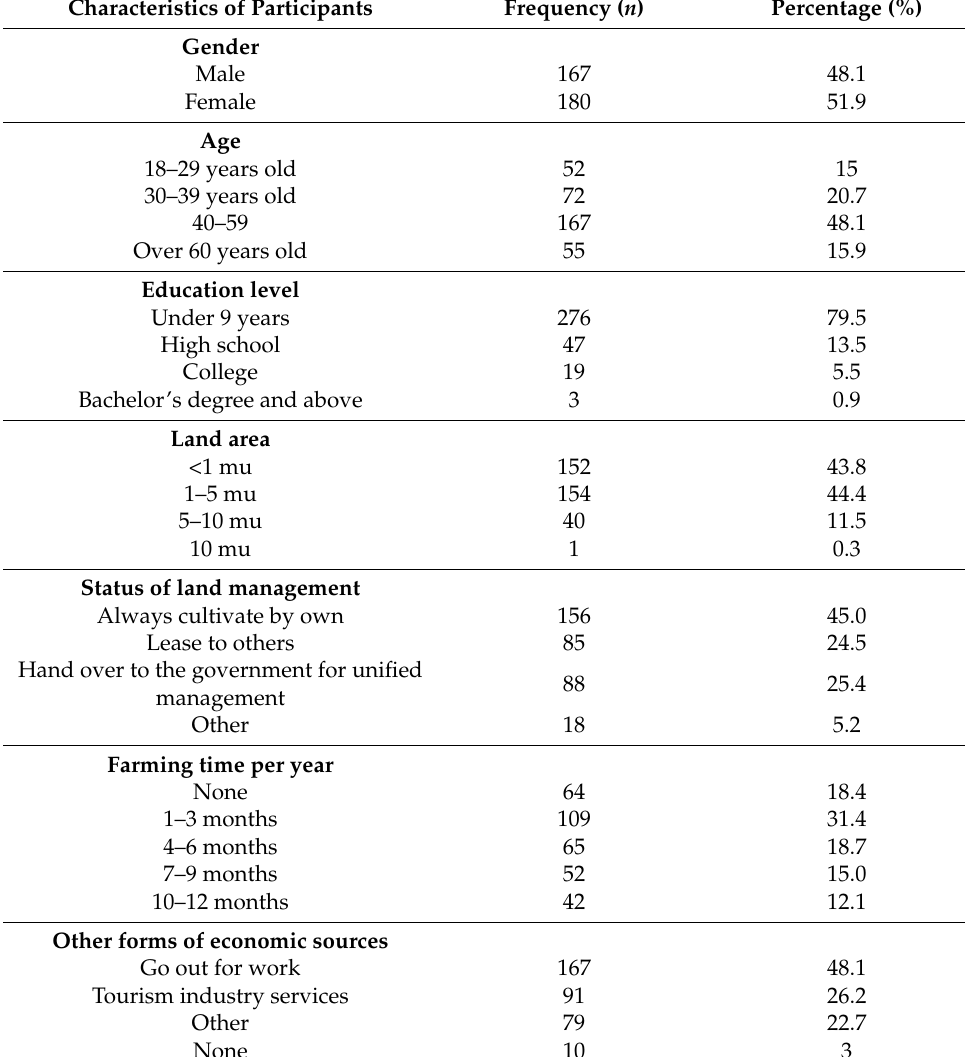
Table 1. Socio-economic characteristics of